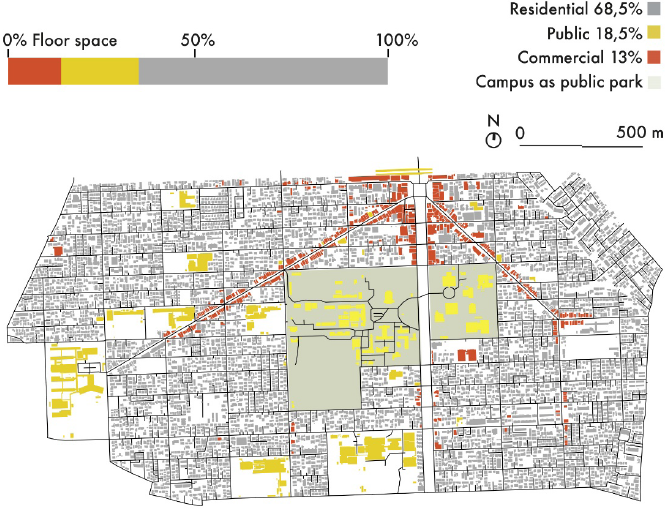
Figure 2. Activities’ distribution in Kunitachi. The color bar refers to the total floor space. The mapping was compiled according to on-site